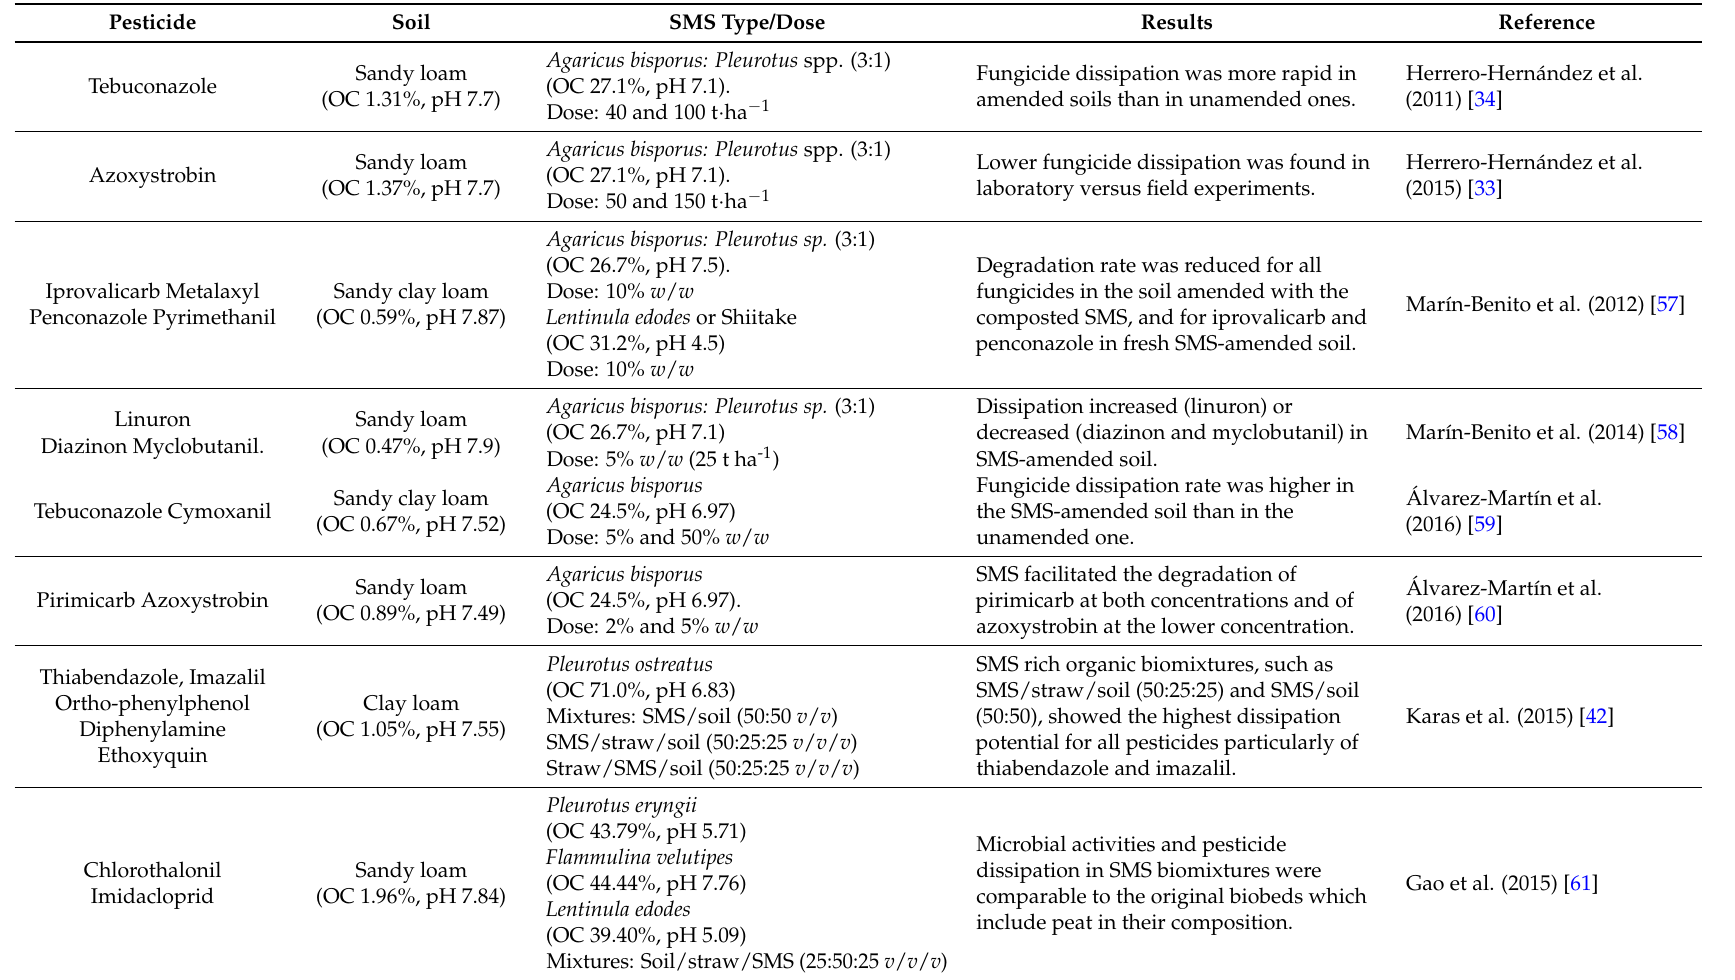
Table 5. Dissipation of pesticides in SMS-amended soils. OM, organic